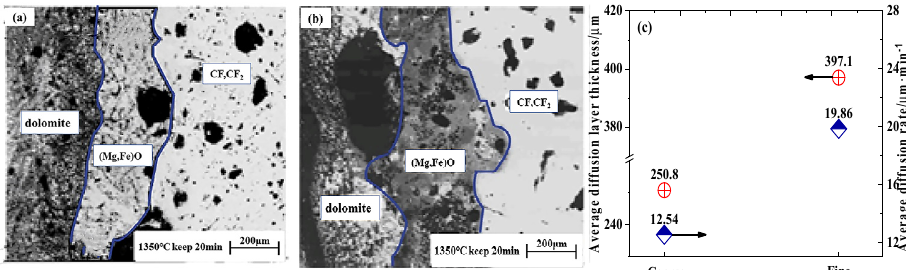
Figure 18. Effects of particle size with dolomite on mineralization rate of sample. ( a ) The SEM of mineralization reaction with coarse dolomite; ( b ) the SEM of mineralization reaction with fine dolomite; ( c ) the effect of particle size with dolomite on mineralization reaction.